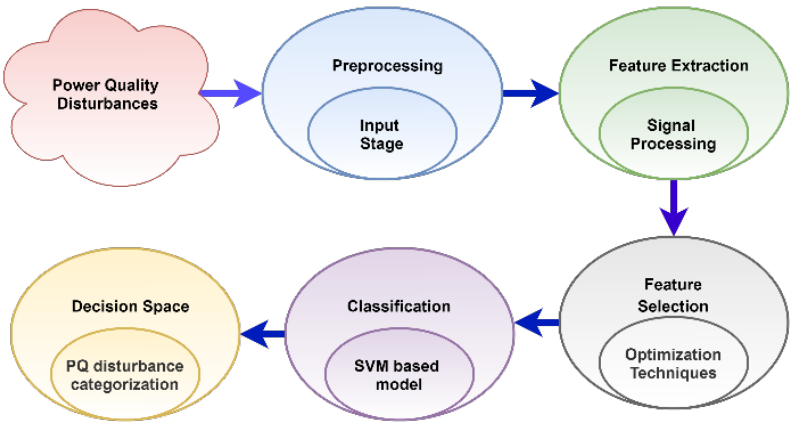
Figure 12. The several stages of power quality disturbances classification by